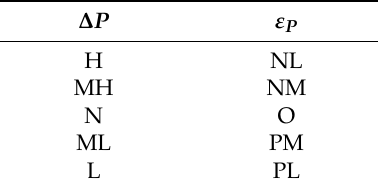
Table 2. Fuzzy Rule base of P -shift.